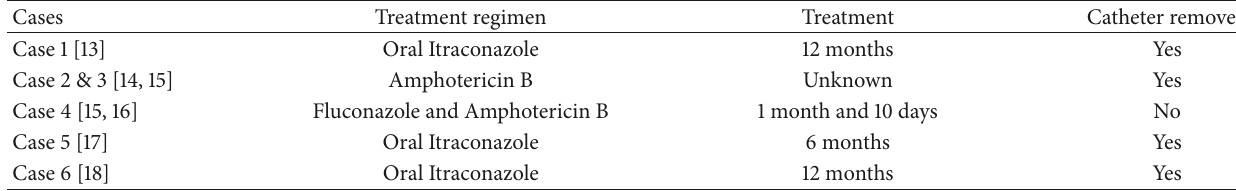
Table 1: Management of reported cases of PD patients with Histoplasma peritonitis.